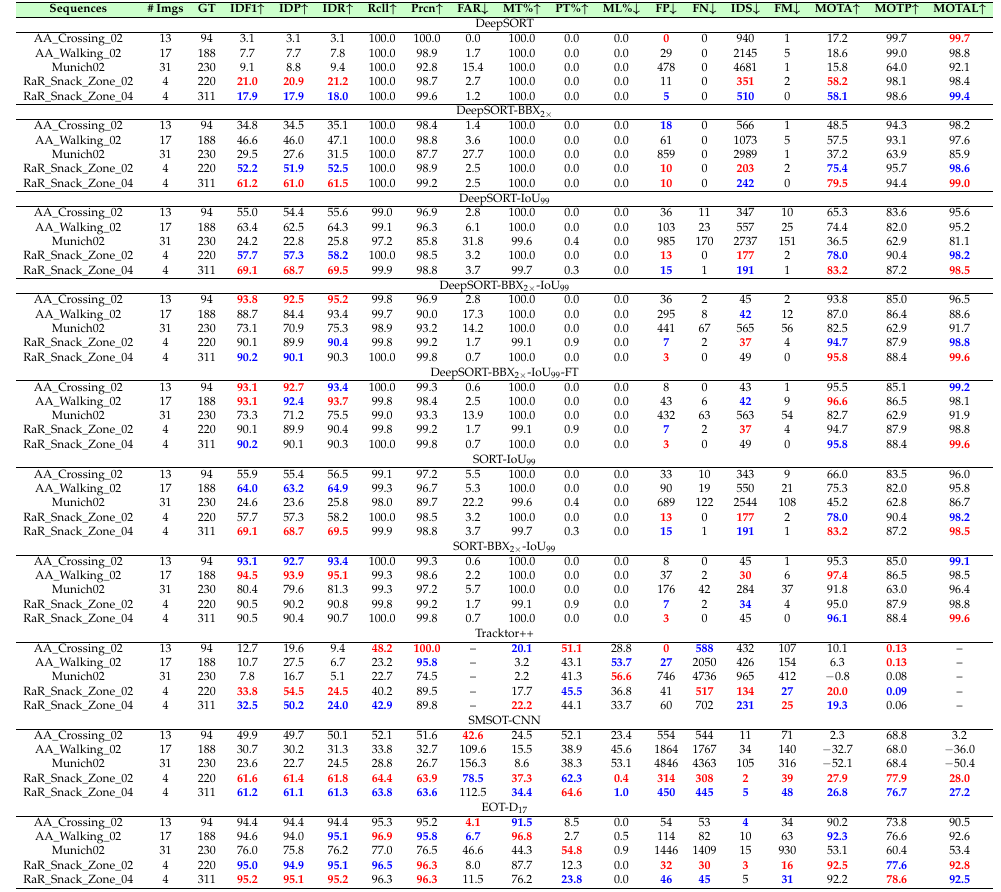
Table 8. Results of DeepSORT, SORT, Tracktor++, and SMSOT-CNN on the KIT AIS pedestrian dataset. The first and second best values of each method on the sequences are